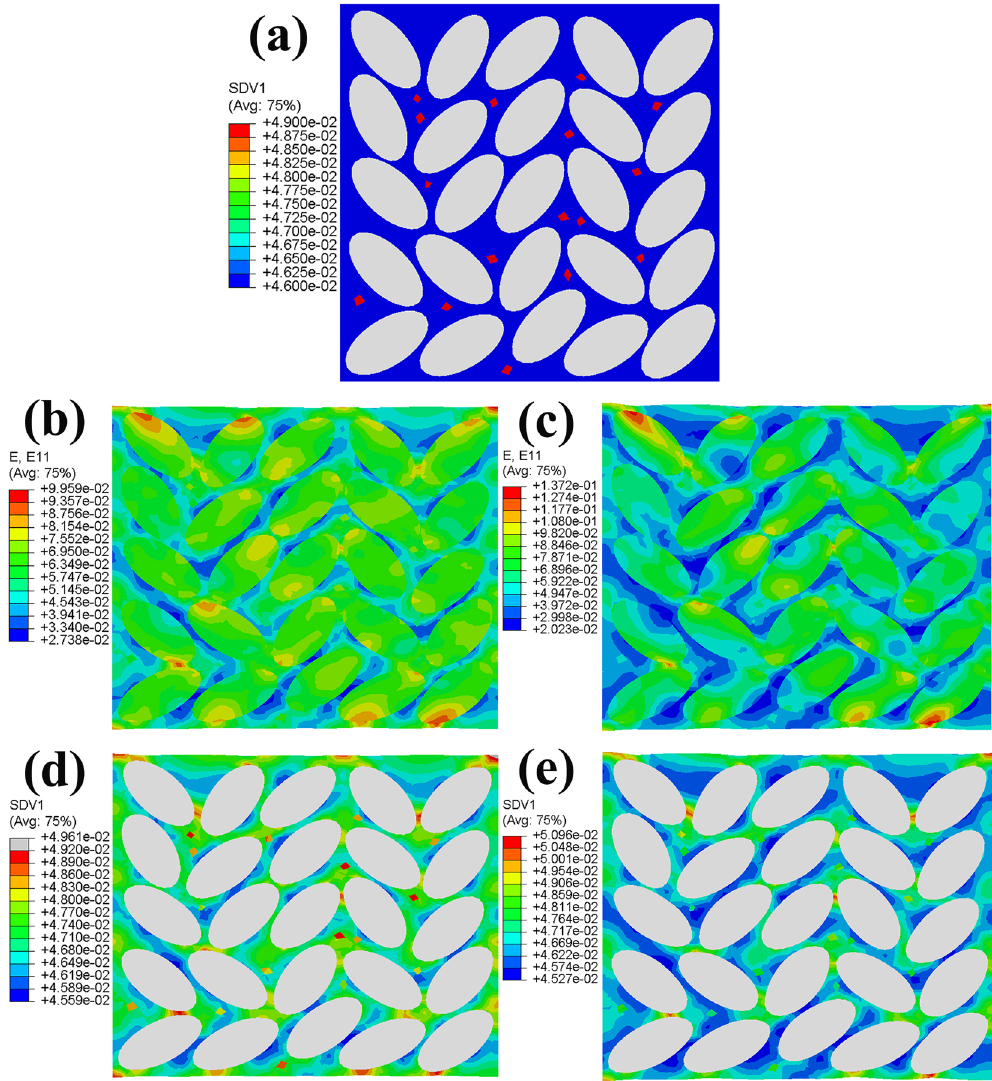
Figure 8. ( a ) The initial state of the composites in FEM, and the maps of strain contours for composite 1 and 2 correspond to Fig. 7(b) with a tensile strain of 6% are shown in ( b ) and ( c ), respectively. ( d ) and ( e ) represent the evolution of shears bands of two different